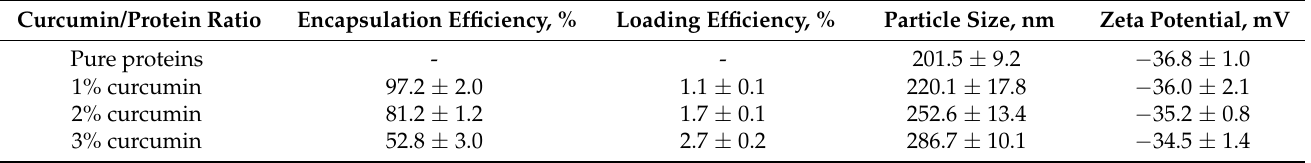
Table 5. Properties of soy protein nanoparticles before and after loading with curcumin. Reprinted with permission from ref. [100]. Copyright 2012 American Chemical Society. Curcumin/Protein Ratio Encapsulation Efficiency, % Loading Efficiency, % Particle Size,